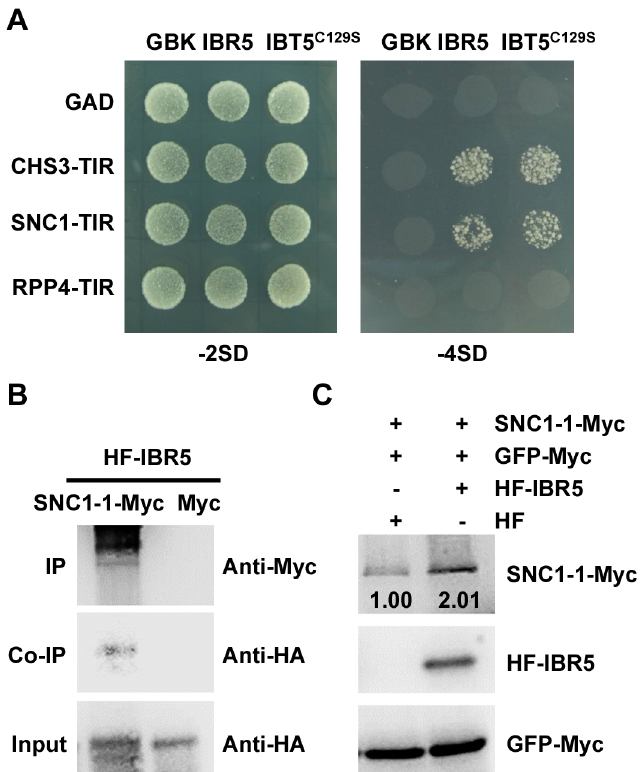
Fig 8. Interaction of IBR5 with SNC1 and RPP4. (A) Interaction of IBR5 with TIR domains of CHS3, SNC1 and RPP4 in yeast. The experiments were performed three times with similar results. (B) Interaction of IBR5 and full-length SNC1 in vivo . Total proteins were extracted from N . benthamiana leaves transfected with 35S : HF-IBR5 and Super : SNC1-1-Myc and were immunoprecipated with an anti-Myc antibody. The proteins from crude lysates (Input) and the immunoprecipated proteins were detected using an anti-HA antibody. (C) The effect of IBR5 on SNC1 protein level in Arabidopsis protoplasts. Super : SNC1-1-Myc and 35S : HF-IBR5 or 35S : HF constructs were co-expressed in Arabidopsis protoplasts. IBR5 was detected with anti-HA antibody and SNC1-1 was detected using an anti-Myc antibody. GFP-Myc construct was used as a control for transformation